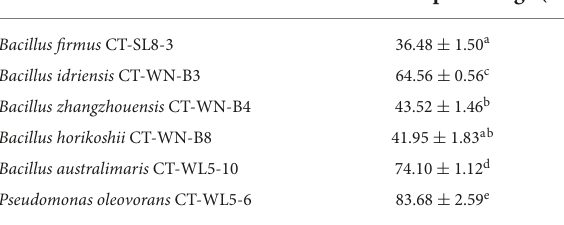
TABLE 1 AN removal percentage of the strains with 10 mg/L initial